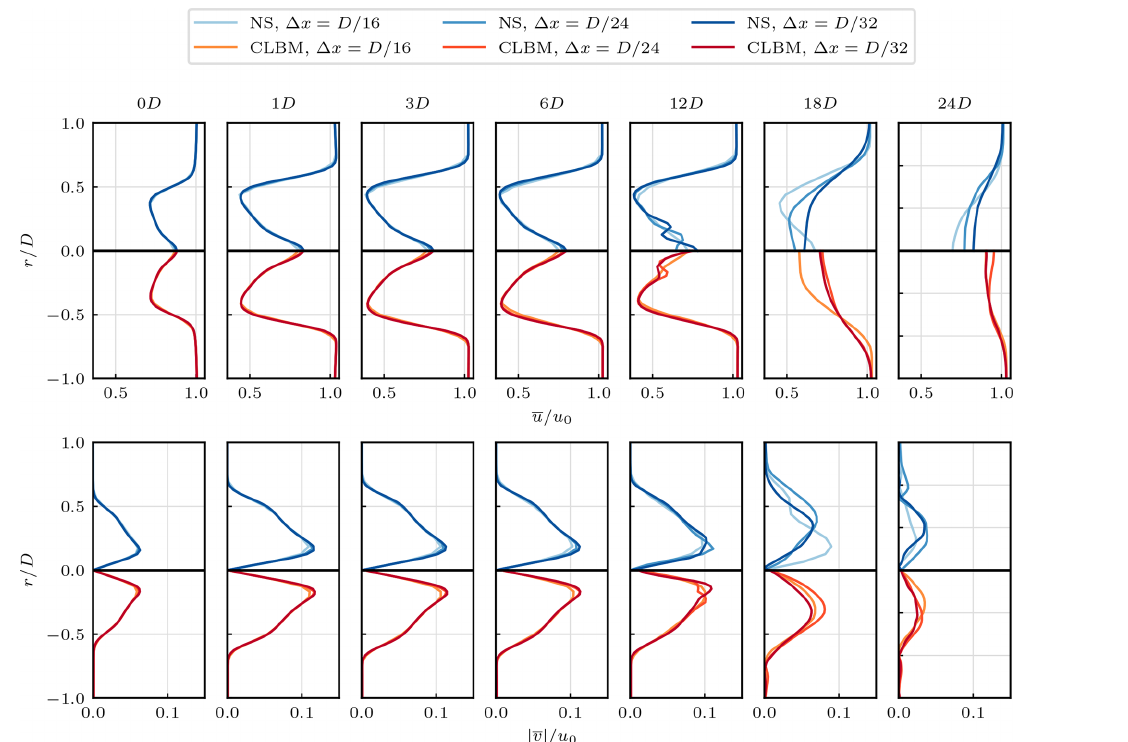
Figure 5. Cross-stream profiles of the mean stream-wise velocity u (top) and tangential velocity v (bottom) of the CLBM compared to the NS reference cases at different downstream positions.